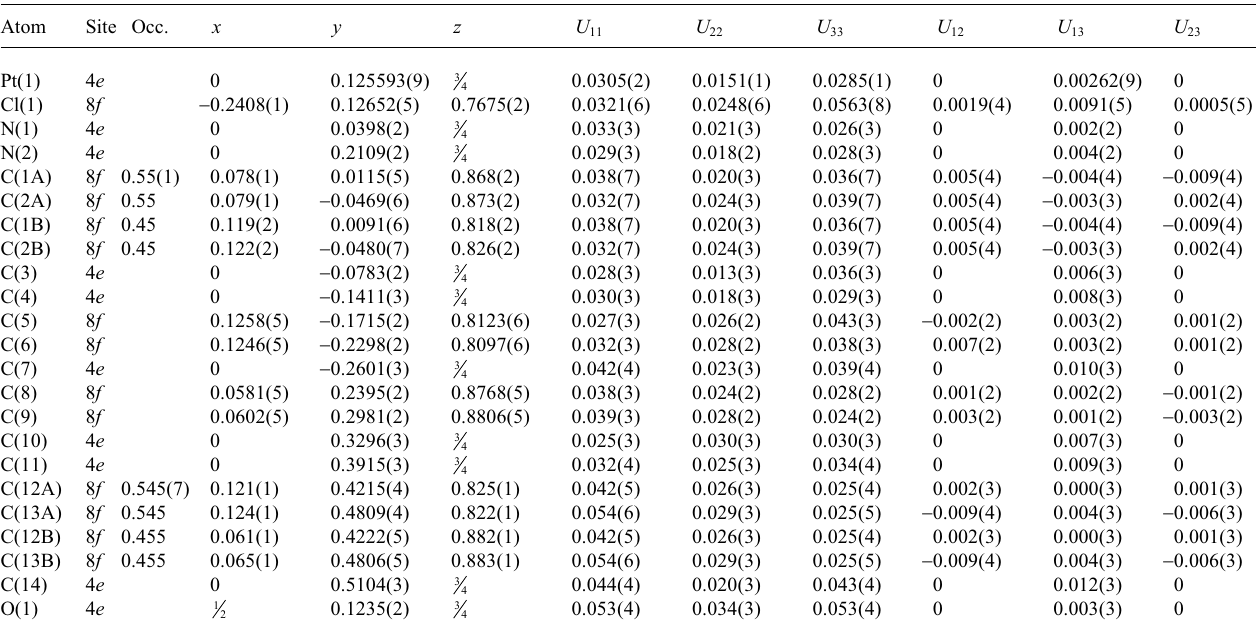
Table 3. Atomic coordinates and displacement parameters (in Å 2